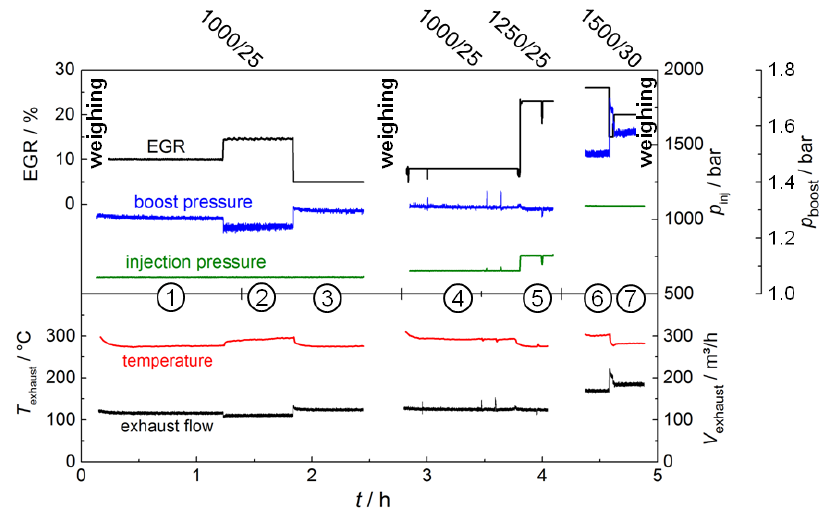
Figure 2. Test procedure: within the seven operation points, different soot concentrations in the exhaust were achieved by varying engine speed, accelerator pedal position, EGR-rate, injection pressure ( p injection ), and boost pressure ( p boost ). Lower graph: resulting exhaust gas temperature and volume flow during the test.